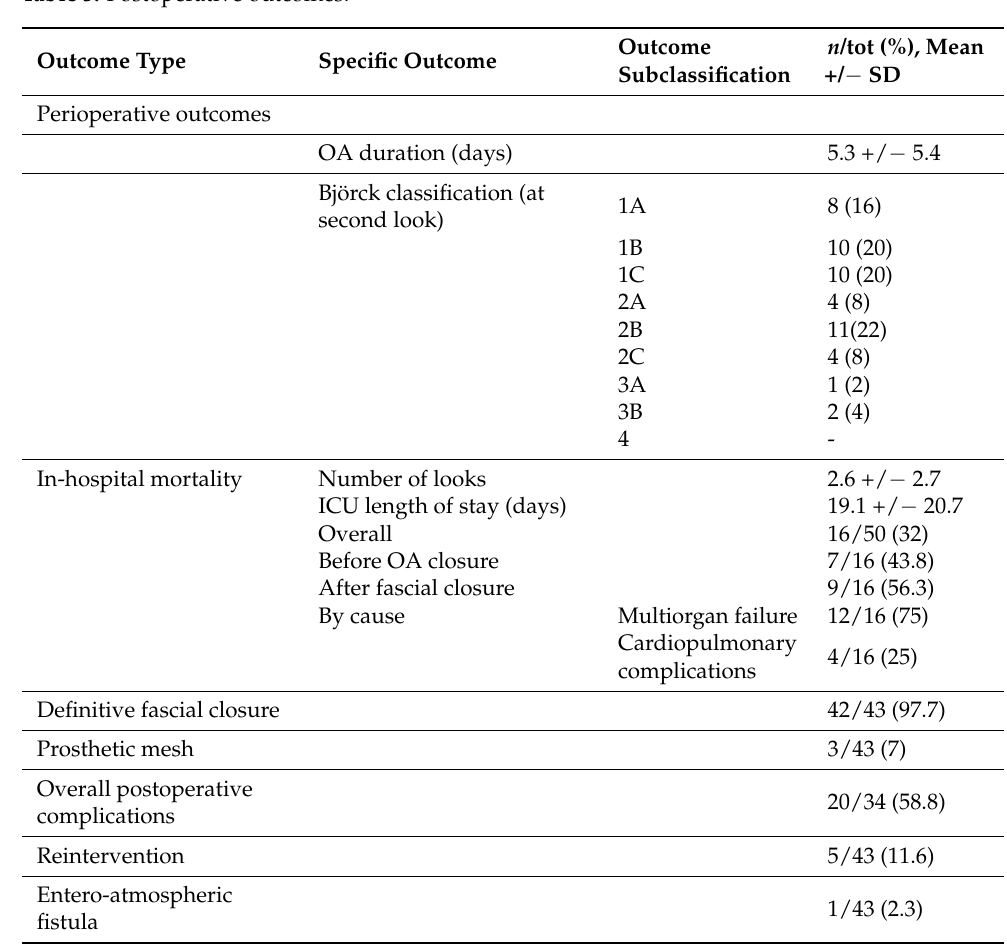
Table 3. Postoperative